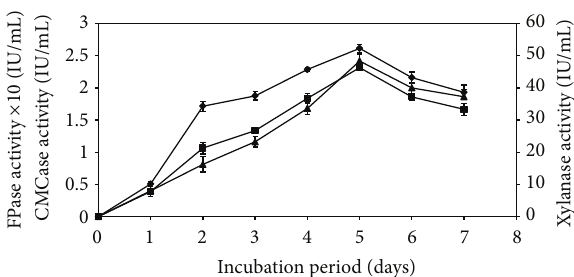
Figure 3: Effect of temperature on CMCase, FPase, and xylanase activities. Results are presented as the mean of three replicates with standard deviation: ( Q ) FPase; ( ◼ ) CMCase; ( 󳵳 ) xylanase.